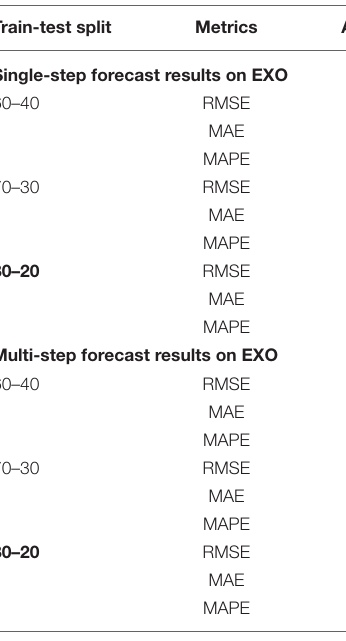
Text in bold denotes the best performance (99% confidence level).